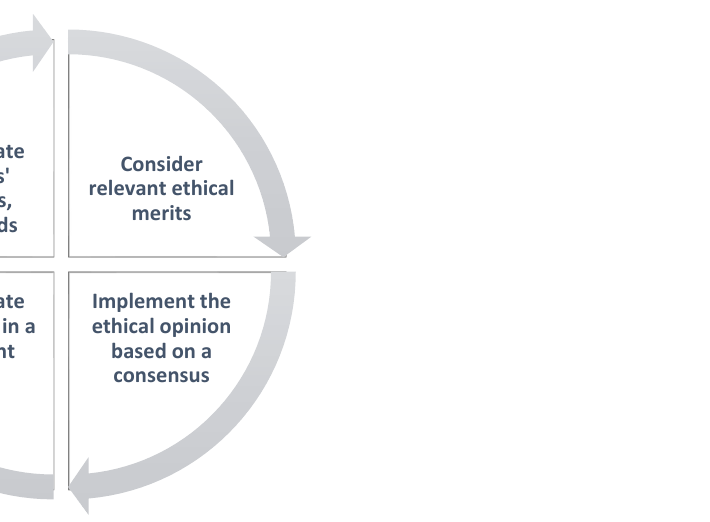
Figure 2. Inner and outer feedback loop mechanisms of ethical and sustainable decision-making process.